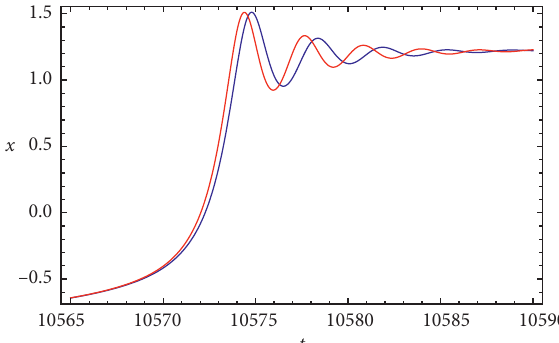
Figure 13: Time history of system (36). The red line represents the curve before time-delay approximation, and the blue line repre- sents the curve after time-delay approximation when the param- � 0 . 01 ,f � 1, and τ � 1 . eters are a � b � α � 1 , ω 2 1